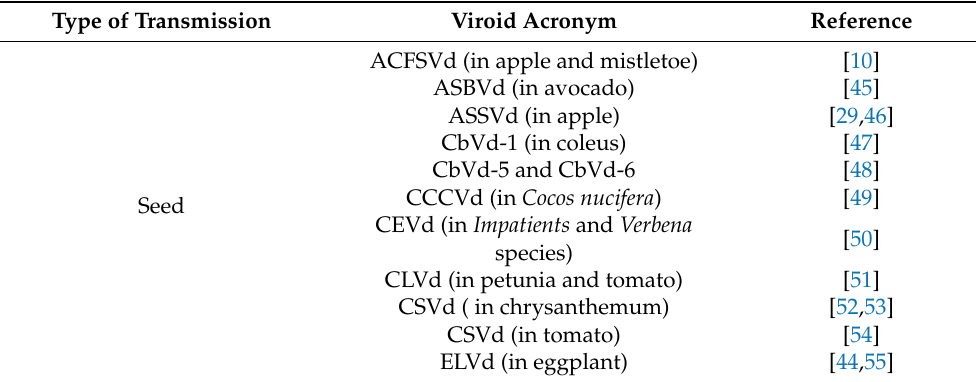
Table 1. Seed and Pollen Transmission of